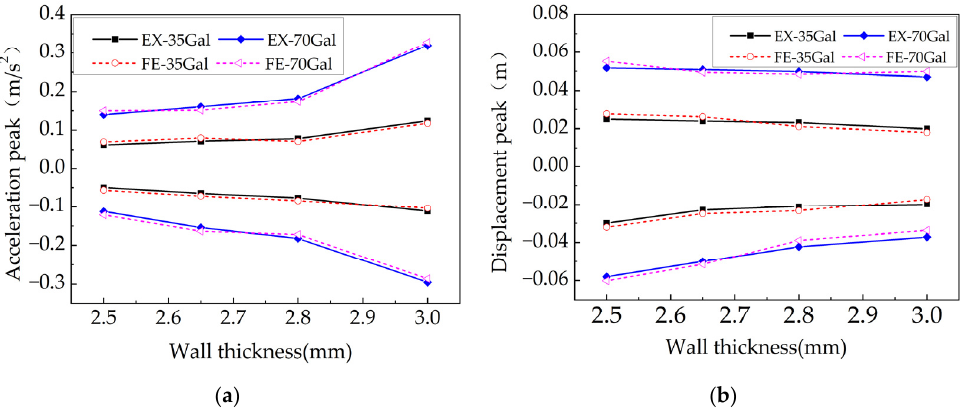
Figure 32. Comparison under the El Centro earthquake: ( a ) Comparison of acceleration peak; ( b ) Comparison of displacement peak.